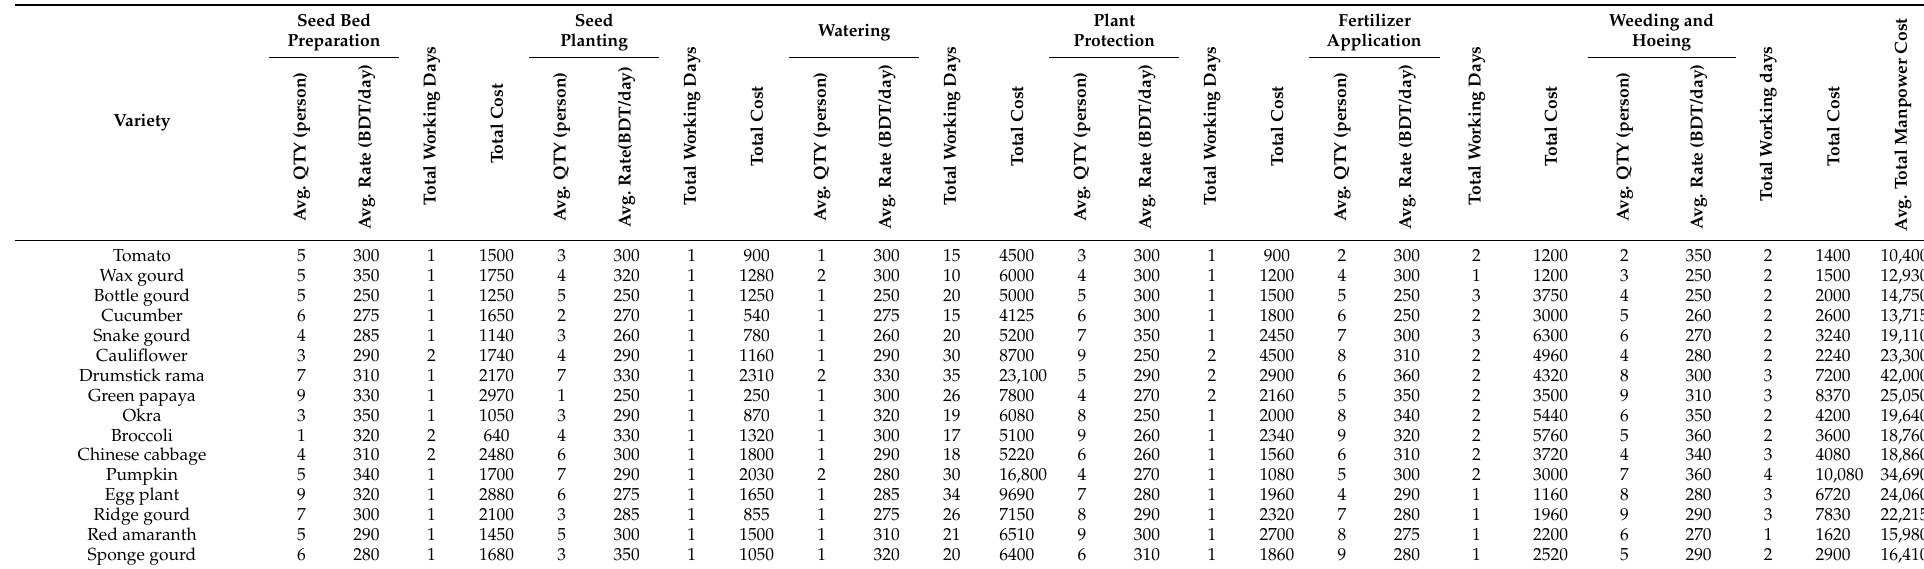
Table 4. Average nursery management cost